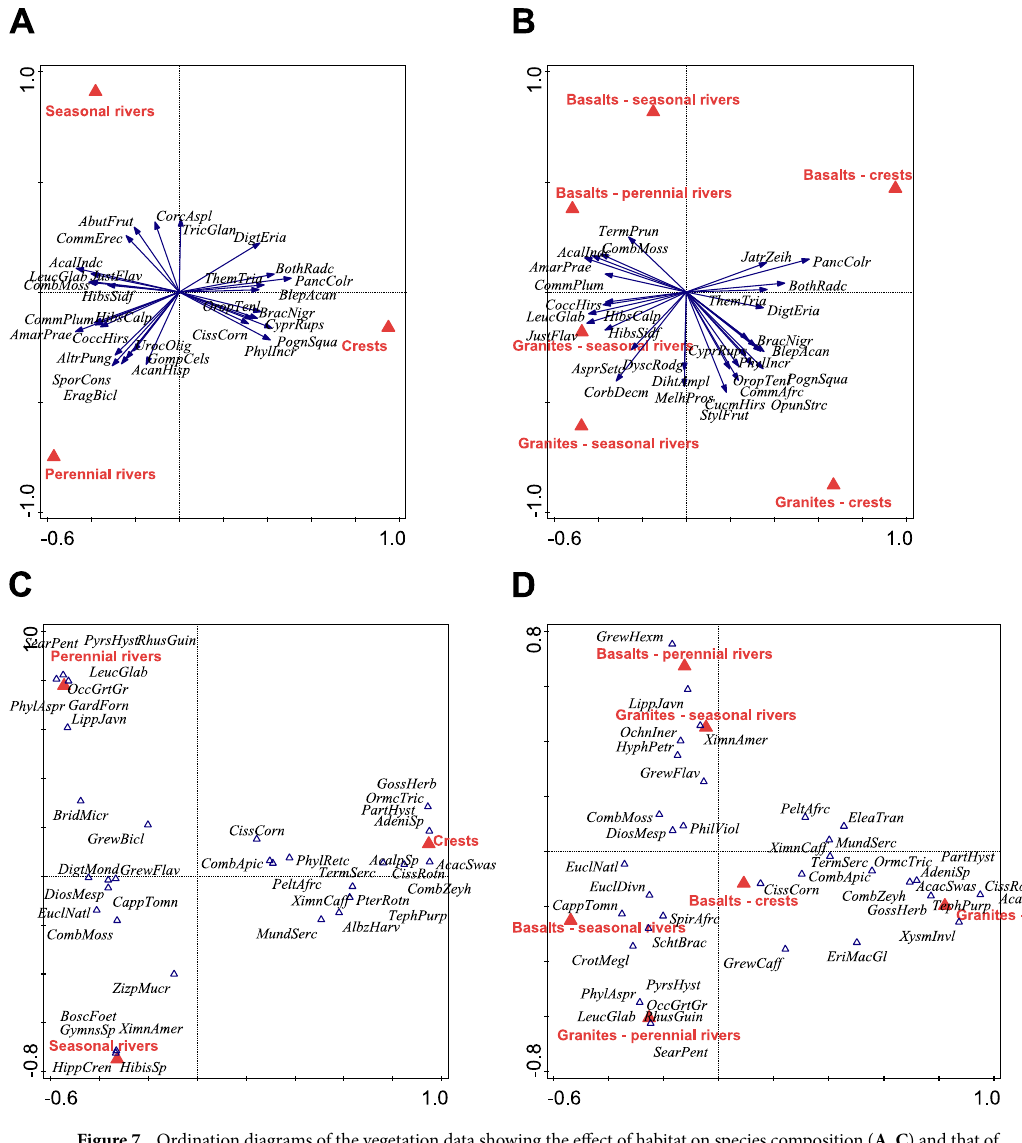
Figure 7. Ordination diagrams of the vegetation data showing the effect of habitat on species composition ( A , C ) and that of habitat × bedrock interaction ( B , D ) separately for herbs (including grasses; top panels A , B ) and shrubs (bottom panels C , D ). The models with herb species as responses ( A , B ) were created using the linear method (RDA), while the ordinations with shrubs as responses ( C , D ) were created using the unimodal models. Species codes: AbutFrut— Abutilon fruticosum , AcacSwas— Acacia swasica